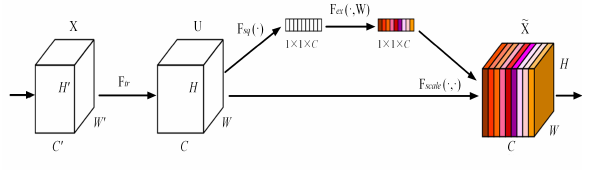
Figure 2. The structure of SE block.